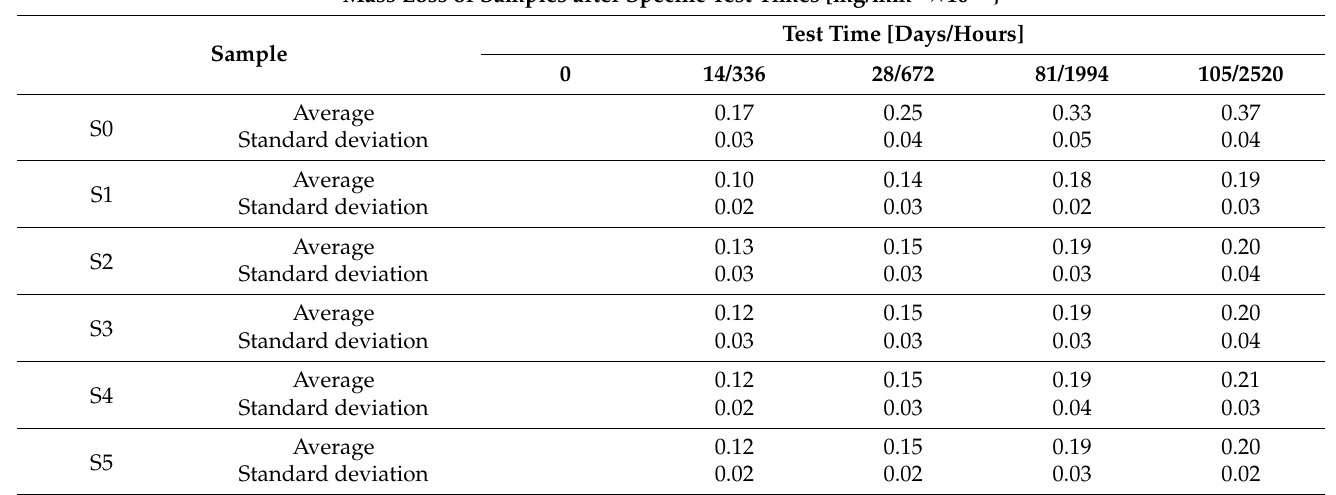
Table 3. Mass losses for particular samples tested in inert brine NSS.